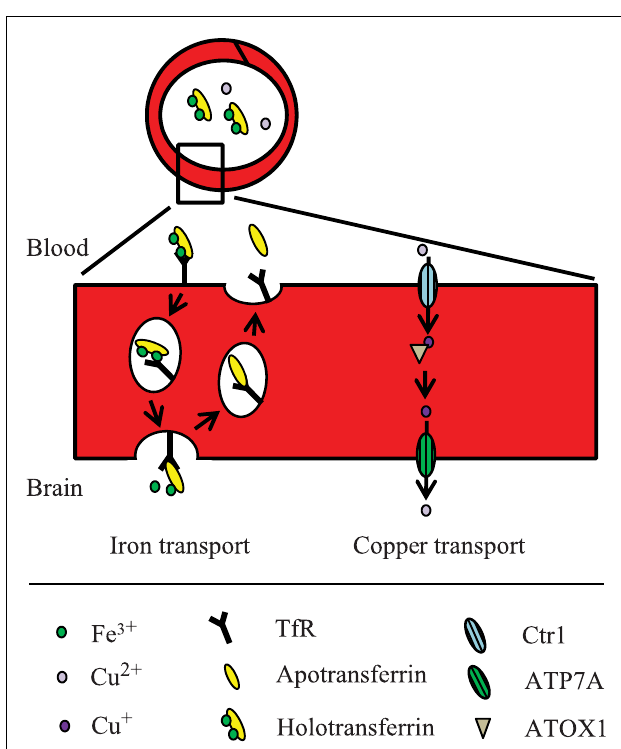
FIGURE 2 | Proposed model for iron and copper transport across the BBB. The mechanisms are described in the